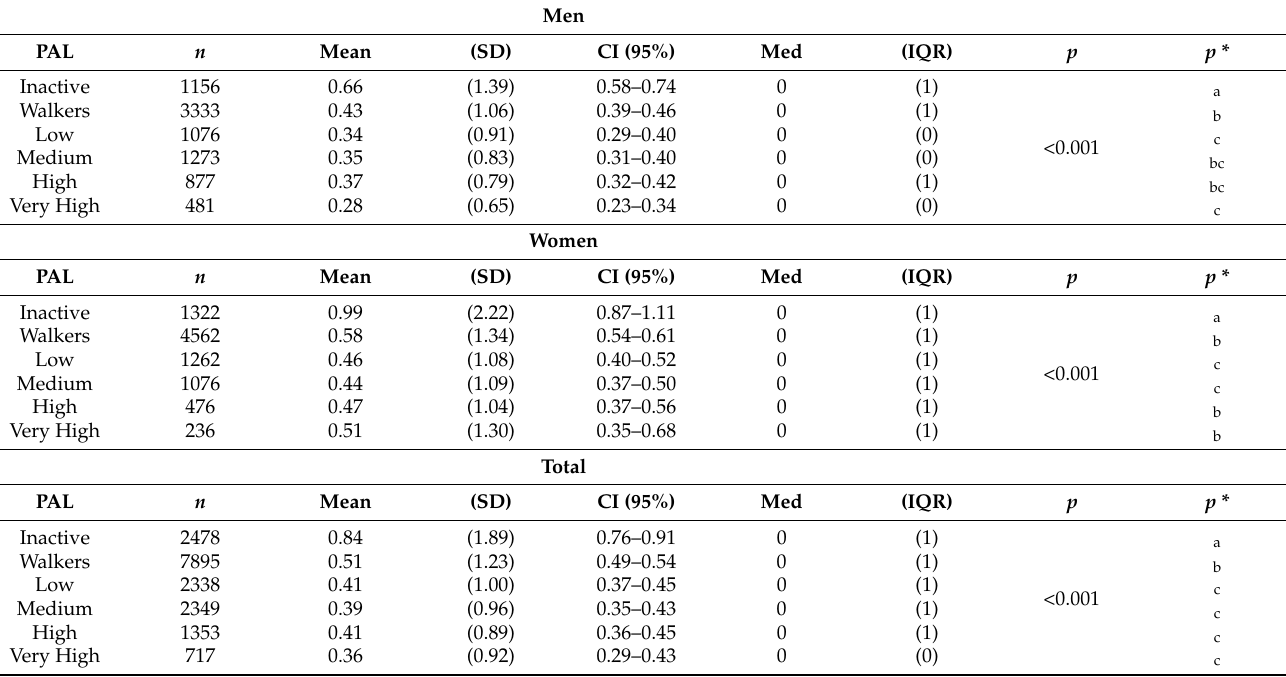
Table 8. Associations between the number of visits to emergency services and physical activity level in the general Spanish population aged 18–69 years compared by sex, according to the ENSE 2017.